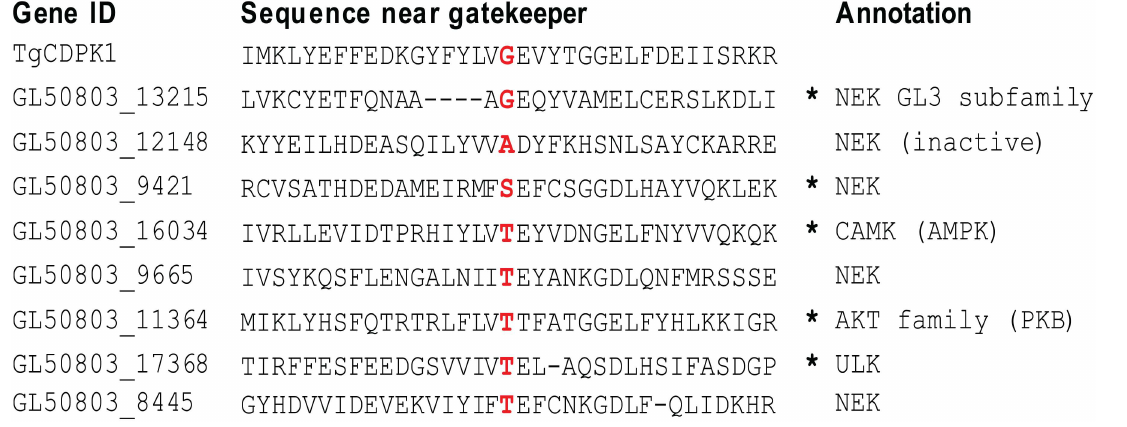
Fig 2. Initial set of eight putative Giardia lamblia small gatekeeper kinases. BLASTP against the Giardia genome database using the T . gondii CDPK1 core kinase domainas a probe found 8 kinases with substantial sequencesimilarity (E < 10 − 24 ) to the probe whose alignment indicateda small gatekeeper residue (threonine or smaller). Sequences near the small gatekeeper are shown with small gatekeeper amino acids in